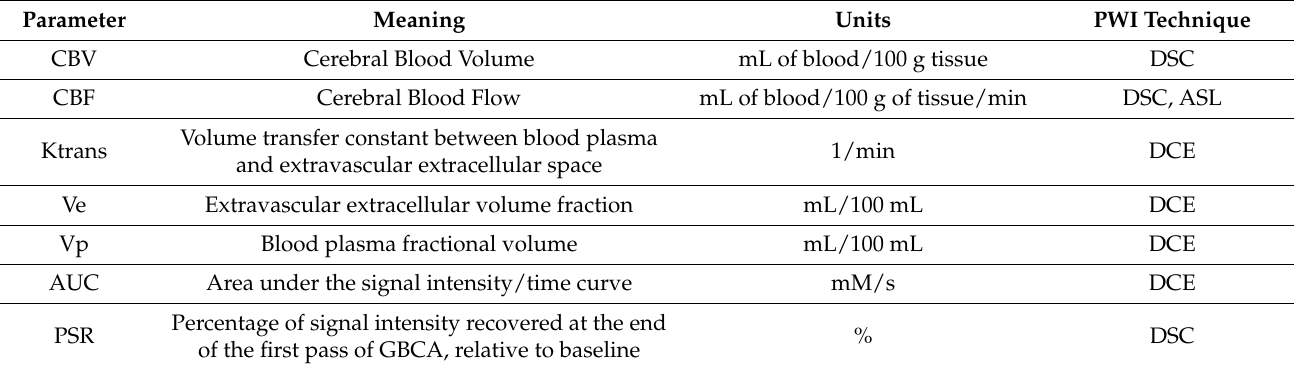
Table 2. Main perfusion techniques parameters in brain